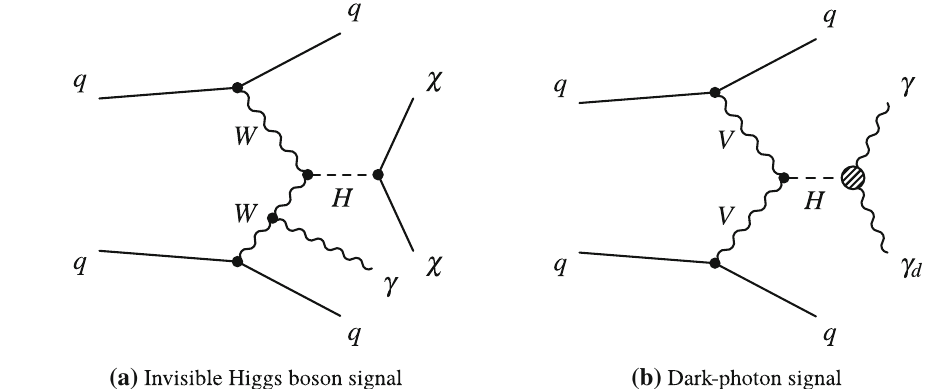
Fig. 2 Representative Feynman diagrams corresponding to the dominant BSM signal processes: a the signal due to the invisible Higgs boson decay produced through VBF in association with an emitted photon. The incoming quarks appearing on the left hand side of the diagram are different from each other. b The signal due to the decay of the Higgs boson to a photon–dark-photon pair, produced through